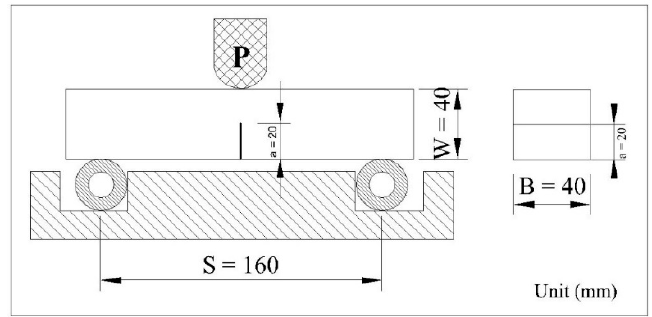
Figure 3. Schematic of three-point bending test for the fracture toughness tests.